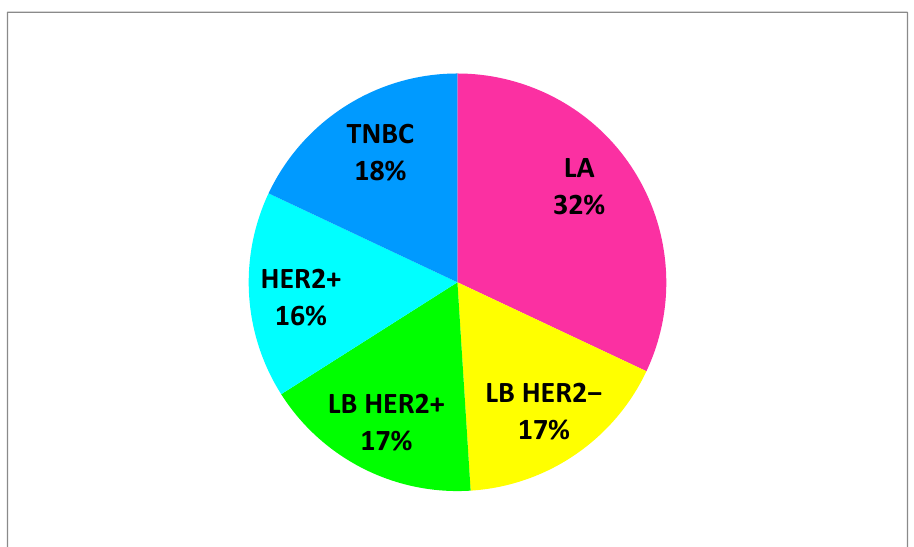
Figure 3. Percentage of specific breast cancer subtypes. LA = luminal A; LB HER2 − = luminal B without HER2 overexpression; LB HER2+ = luminal B with HER2 overexpression; HER2+ = human epidermal growth factor receptor 2 positive; TNBC = triple negative breast cancer.